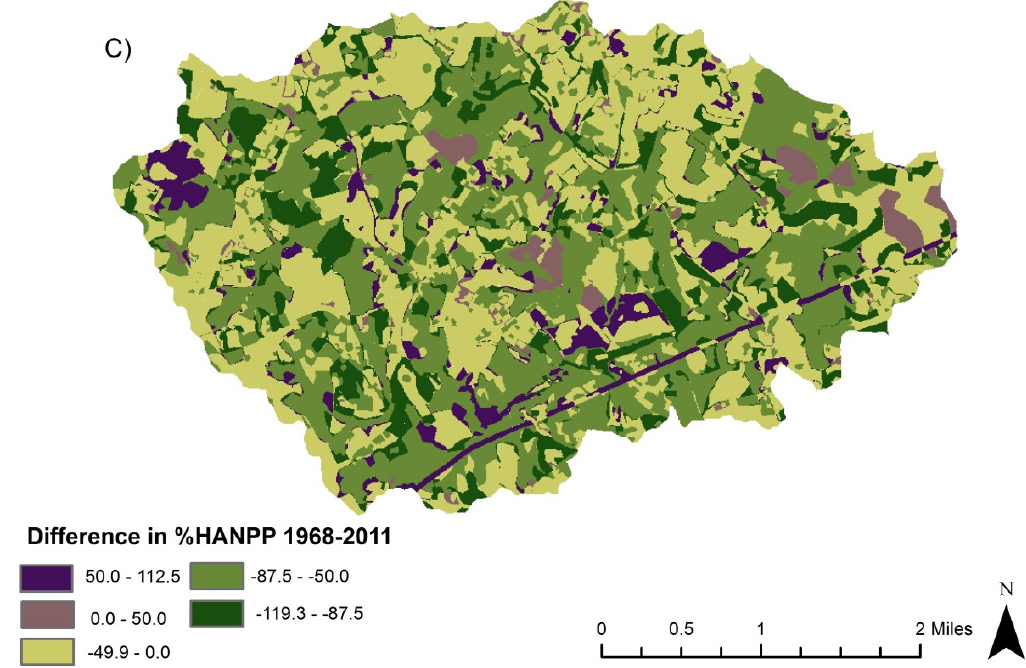
Figure 9. Spatial distribution of percent HANPP (HANPP/NPP pot ) for ( A ) 1968; ( B ) 2011, and ( C ) the